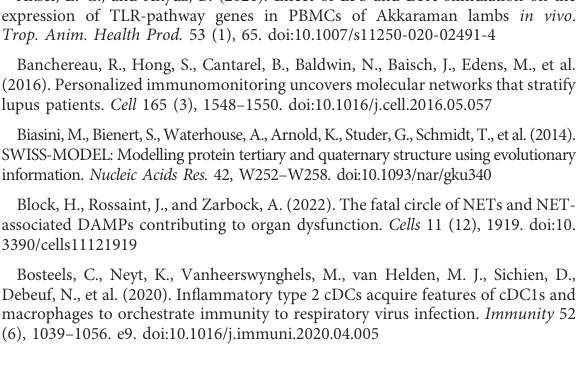
SUPPLEMENTARY FIGURE S1 Multiple alignments of the TLR4 amino acid sequence among giant pandas, humans, mice, and monkeys. SUPPLEMENTARY FIGURE S2 Transcriptomic pro fi les of LPS-stimulated and -unstimulated PBMCs from mice by RNA-seq. (A) Flow diagram of the experimental design. (B) VolcanoplotshowstheDEGsbycomparingtheLPS-stimulatedPBMCs and LPS-unstimulated PBMCs from mice at the time point of 6 h. Signi fi cantly differentiallyexpressedgeneswerede fi nedbybothp-value (less than and equal to 0.05) and fold change (greater than and equal to 2). (C) GO and KEGG enrichments of upregulated DEGs for the group of LPS-stimulatedPBMCsvs.LPS-unstimulatedPBMCsfrommicebyRNA- seq. (D) GO and KEGG enrichments of downregulated DEGs for the group of LPS-stimulated PBMCs vs. LPS-unstimulated PBMCs from mice by RNA-seq. SUPPLEMENTARY FIGURE S3 Transcriptomicpro fi lesofLPSstimulatedand-unstimulated PBMCsfrom monkeys by RNA-seq. (A) Flow diagram of the experimental design. (B)